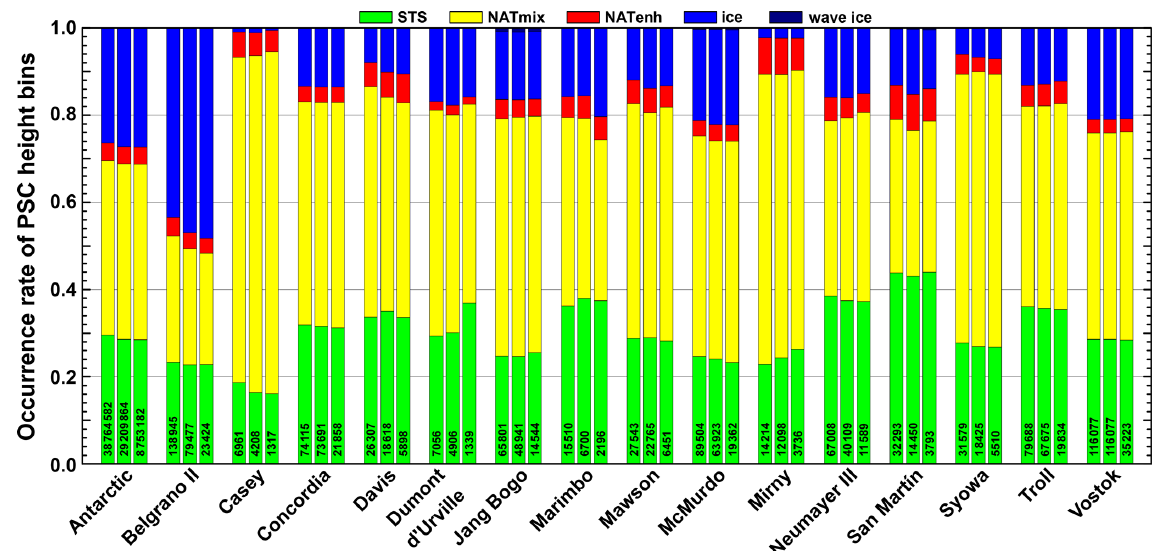
Figure 7. Same as Fig. 4 but for Antarctic